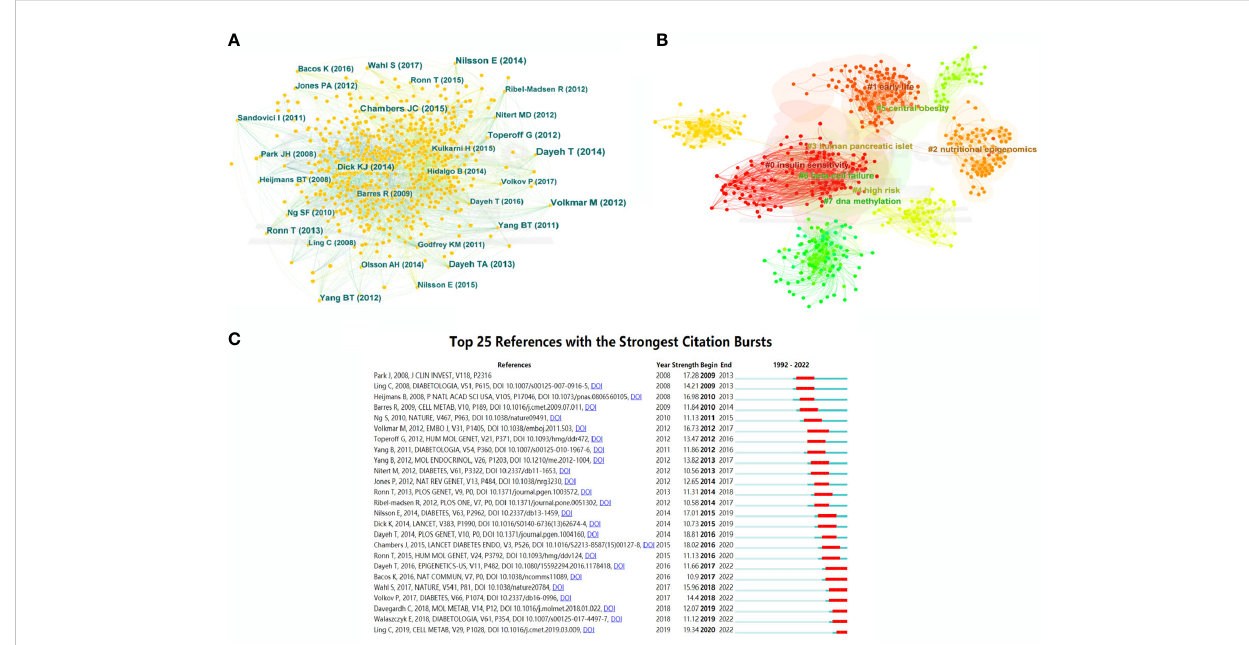
FIGURE 6 Bibliographic analysis of cited references. (A) Map of cited references. Different sizes denote the quantity of publications for cited references, and the distance between the two circles represents the relatedness between them. (B) A clustering map of topics for cited references. Each area with a colorful node represents the keyword clusters of the cited references. (C) The top 25 references with the strongest citation burst in T2DM- methylation modi fi cation